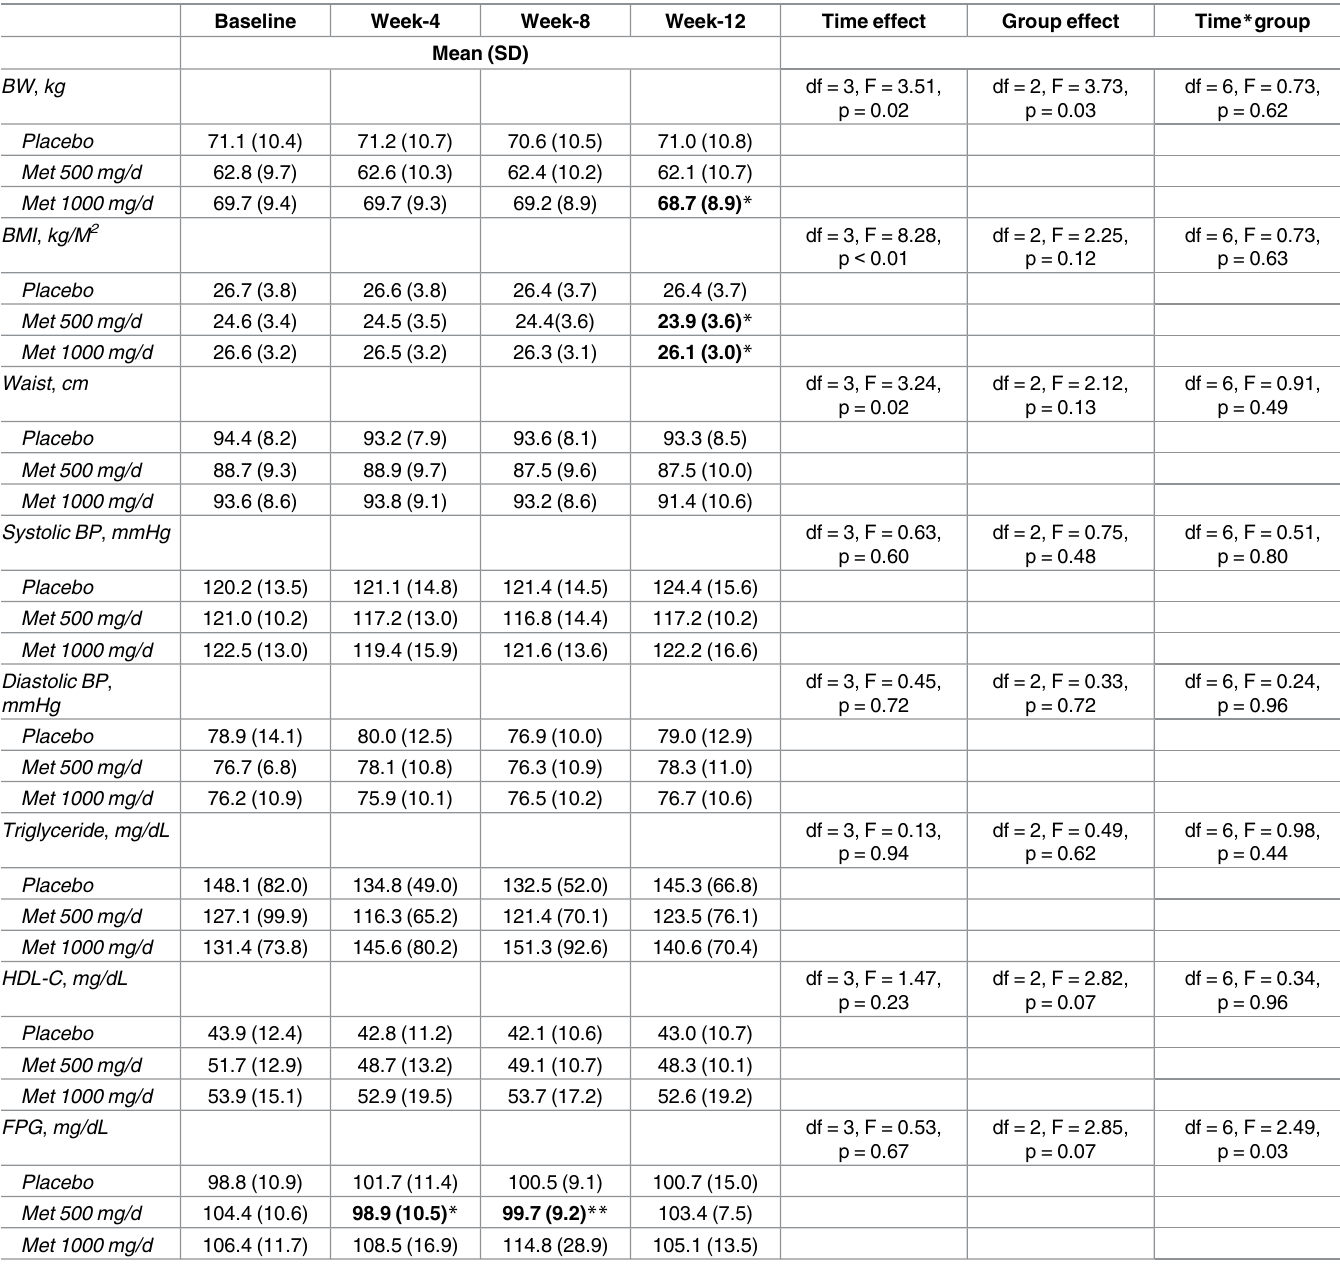
Table 3. Changes of metabolic traits among patients in placebo, metformin at 500 mg/d, and metformin at 1000 mg/d groups.